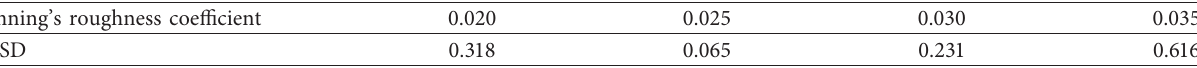
Table 2: RMSD values for Manning’s n .